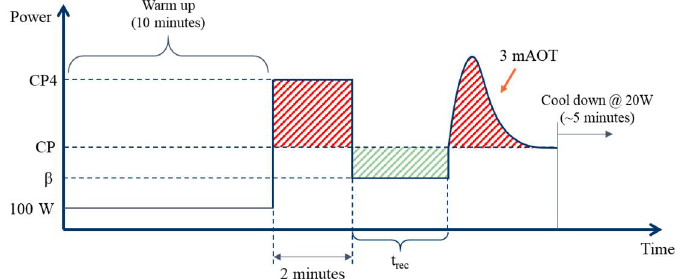
Figure 1. Intermittent cycling test